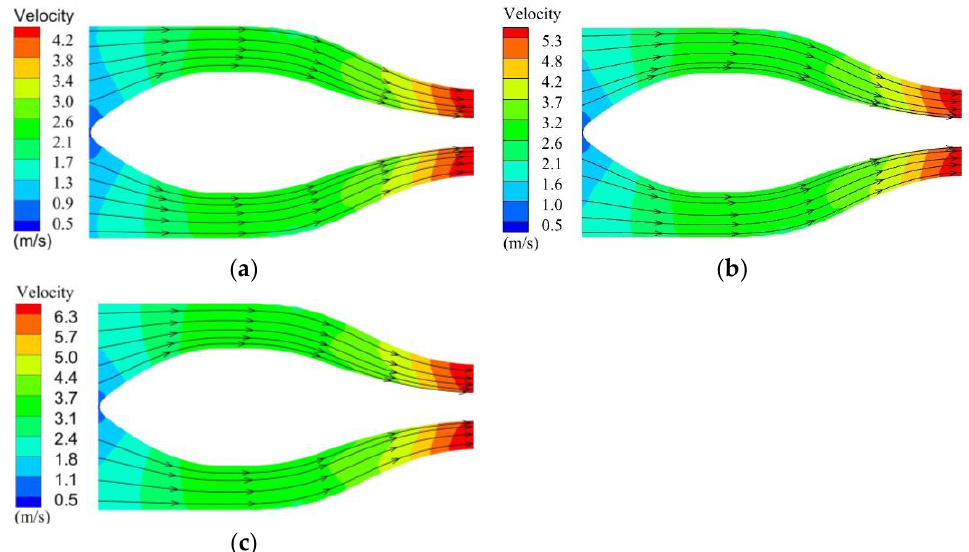
Figure 6. Velocity distribution of cross-section in inlet passage: ( a ) Q = 0.8 Q bep ; ( b ) Q = 1.0 Q bep ; ( c ) Q = 1.2 Q bep .